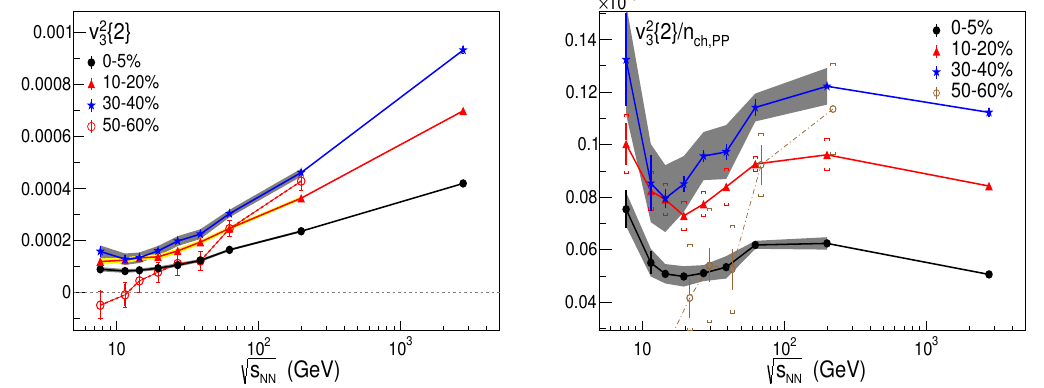
{ 2 } for four centrality bins. Points at 2.76 TeV 3 { 2 } divided by n ch,PP pair. Reproduced from Ref. 3